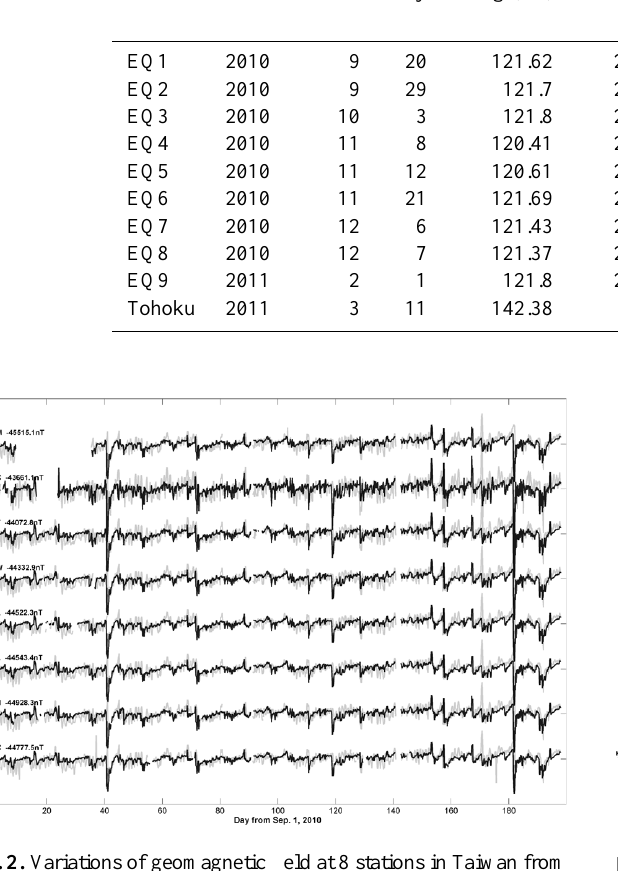
Fig. 3. First panel: variations of the ULF amplitudes observed from 1 Septemebr 2010 to 17 March 2011, at the NC station at two fre- quency bands, 0.01–0.001Hz and 0.1–0.01Hz. Second panel: ULF variations observed during the period from 20 September 2010 to 10 Octtober 2010. Note that red and blue lines denote the processed amplitude at 0.01–0.1Hz and 0.001–0.01Hz, respectively. Third panel: Dst parameter variation versus the investigated period (i.e. 1 September 2010 to 17 March